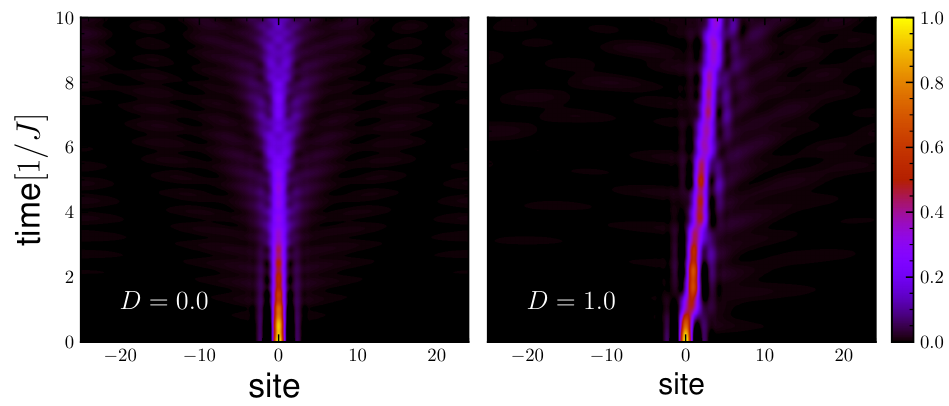
| b † | ψ 〉 ver- b t j t j